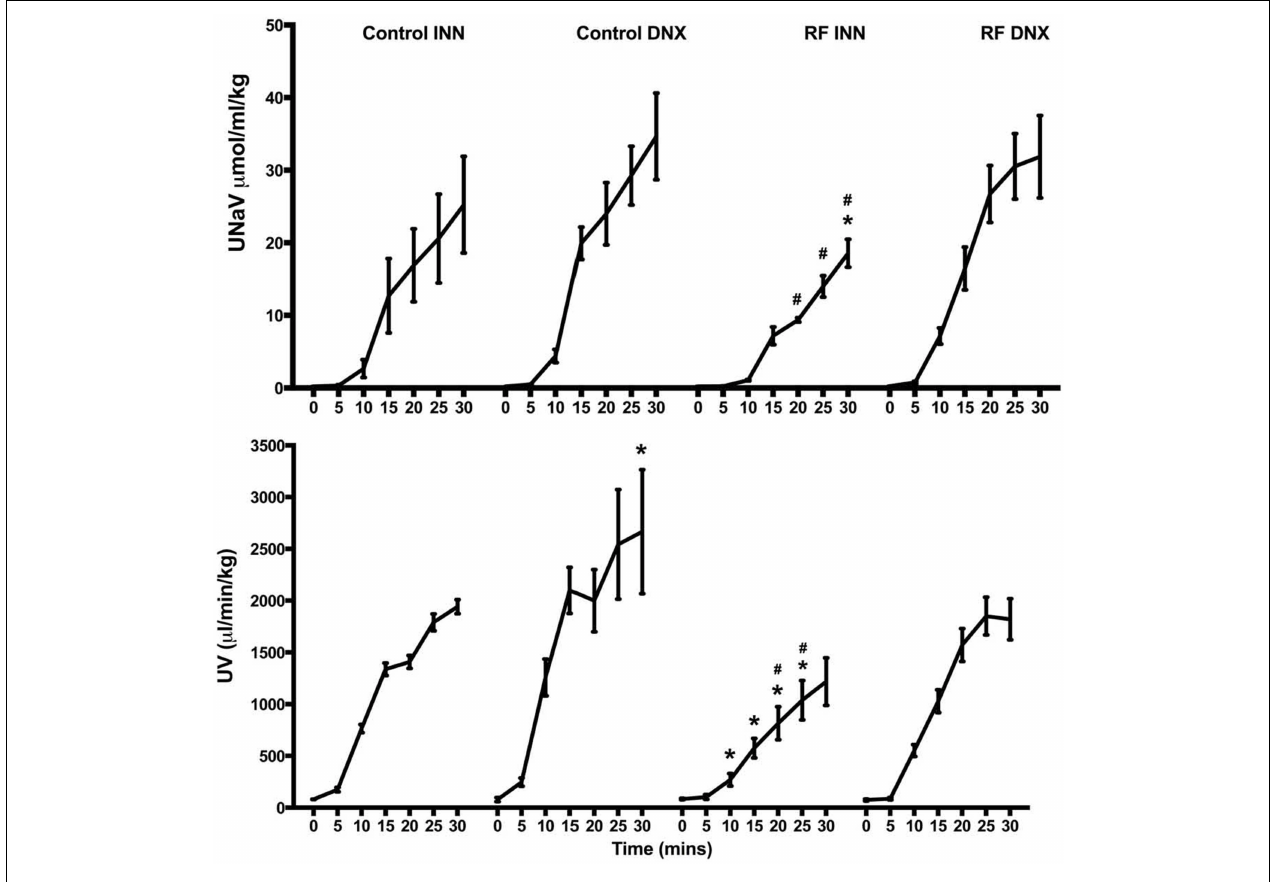
FIGURE 8 | This presents the values of urine flow (UV) and sodium excretion (UNaV) for each of the 5min periods during the 30min of saline volume expansion in control, control renally denervated rats (control DNX), cisplatin treated renal failure (RF) and renally